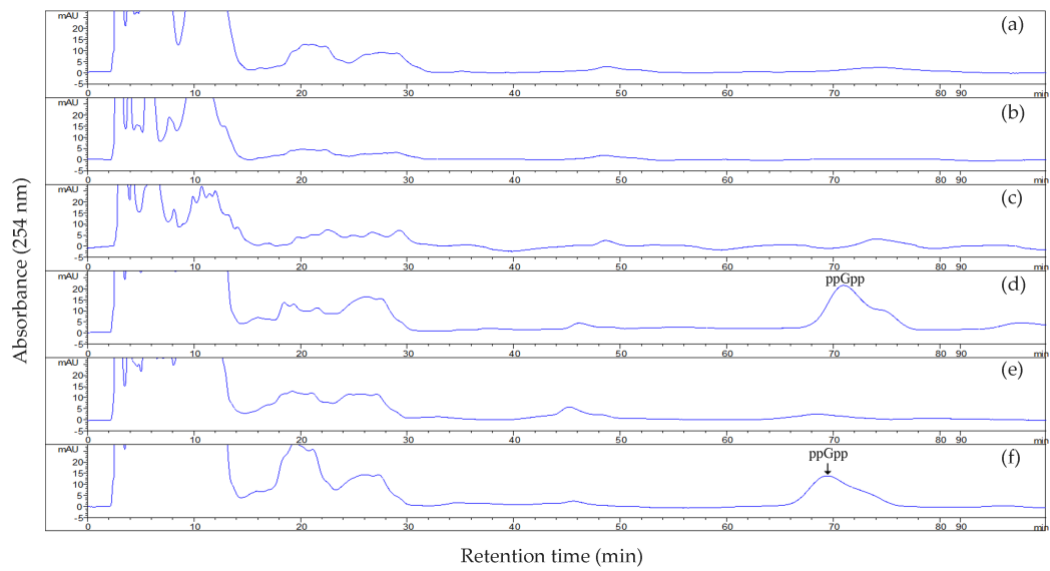
Figure 3. ppGpp accumulation in strain US6-1, ∆ rsh and ∆ rsh (pCM62-rsh) in different growth phases. Levels of ppGpp in cultures of US6-1 ( a , d ), ∆ rsh ( b , e ) and ∆ rsh (pCM62-rsh) ( c , f ) in the exponential growth phase (36 h) and in the stationary phase (72 h) were monitored by reverse phase high-performance liquid chromatography (HPLC) analysis. The eluted nucleotides were monitored at 254 nm and identified by comparison with the retention time of 100 µM ppGpp standard. ppGpp standard was eluted at 71 min under the current conditions and the position is indicated by an arrow.